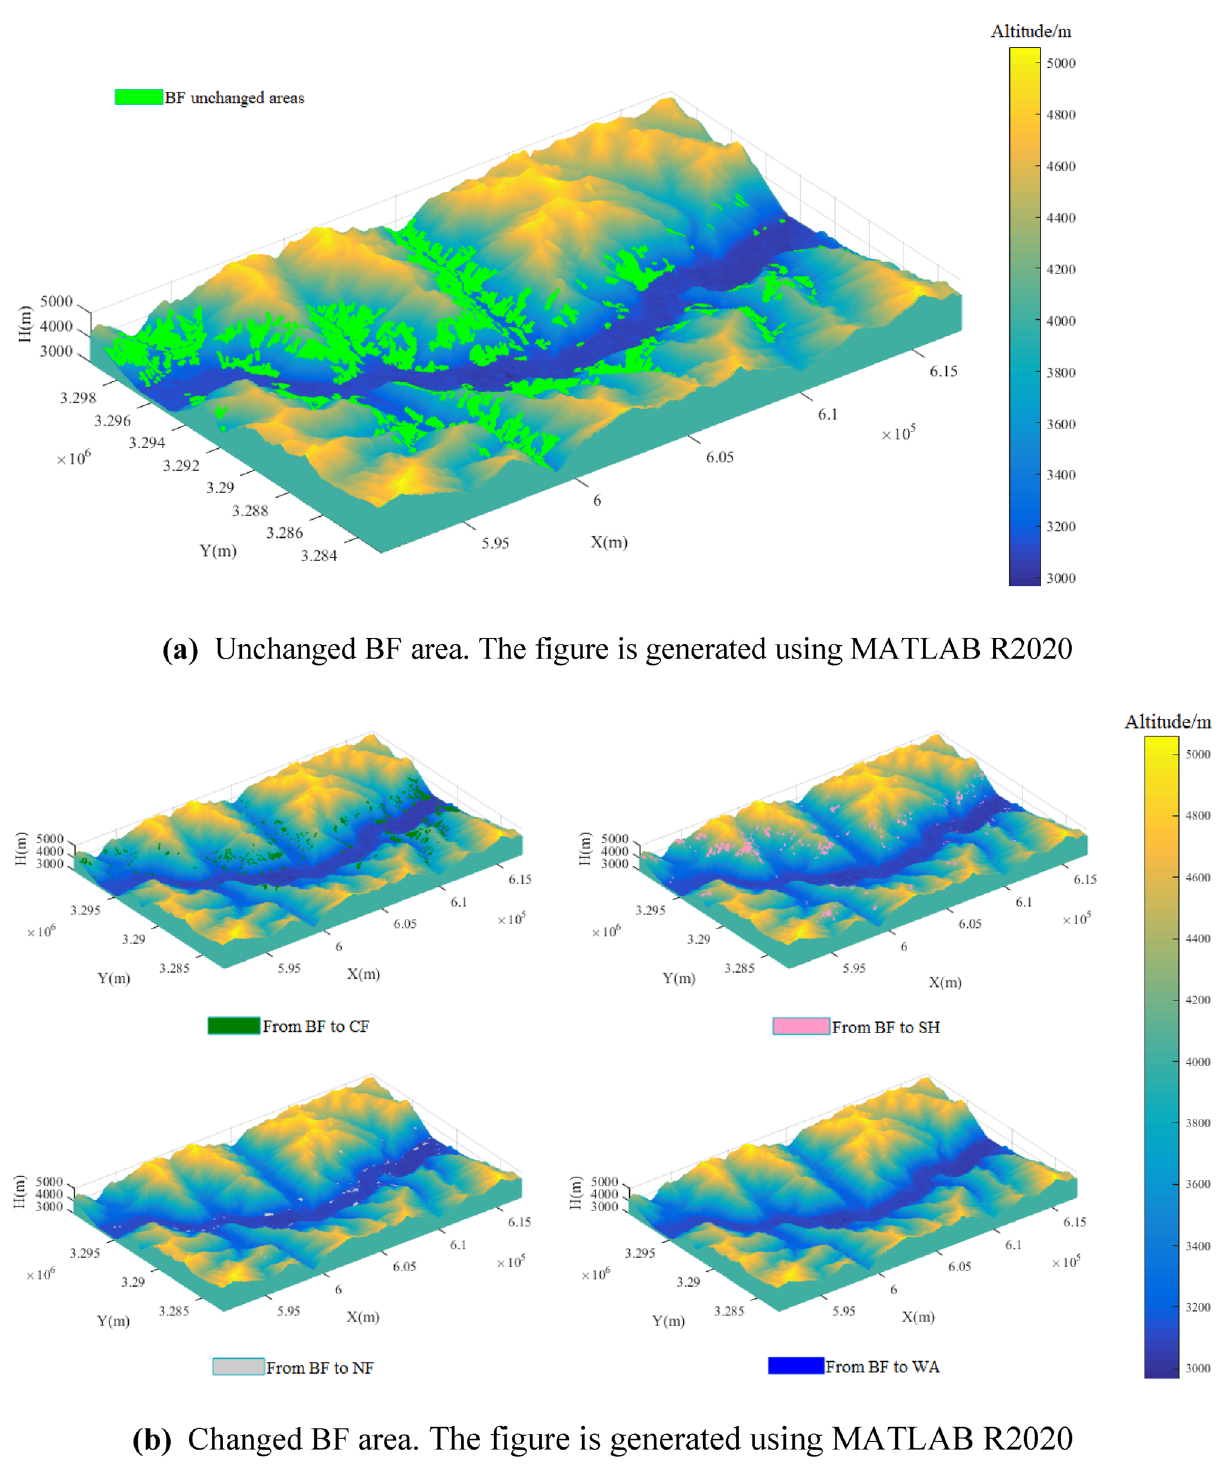
Figure 7. (a) Unchanged BF area. The figure is generated using MATLAB R2020 (http:// www. mathw orks. com). (b) Changed BF area. The figure is generated using MATLAB R2020 (http:// www. mathw orks.